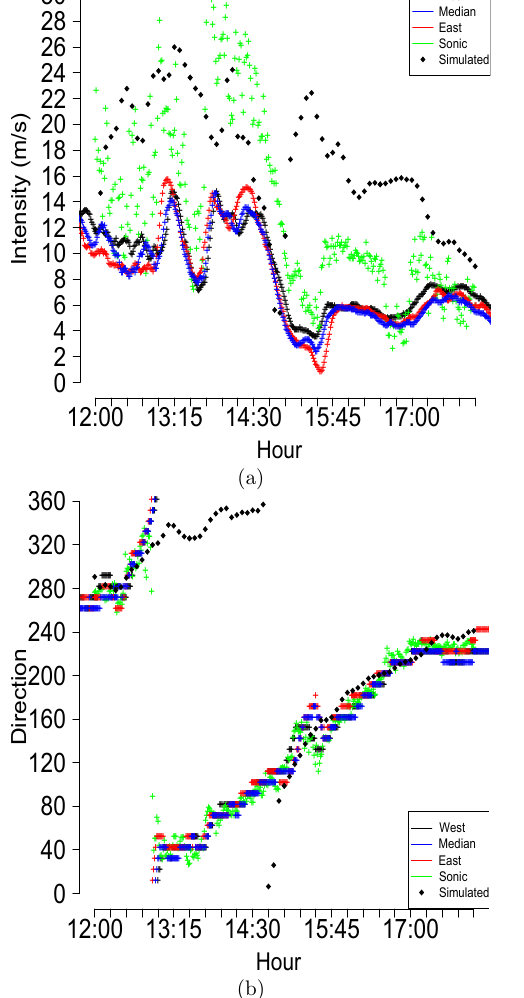
Fig. 14. Time series: each minute of 10m wind intensity (a) and direction (b) between 12:00UTC and 18:00UTC on 24 March 2009 observed by the four airport anemometers and simulated by Meso- NH.